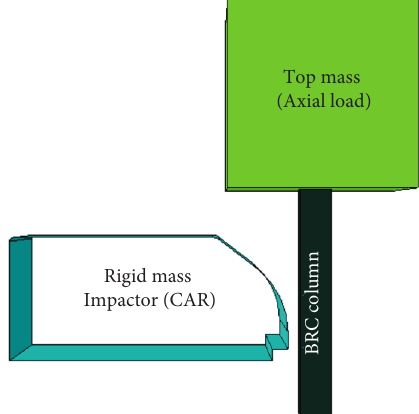
Figure 4: Schematic representation of the